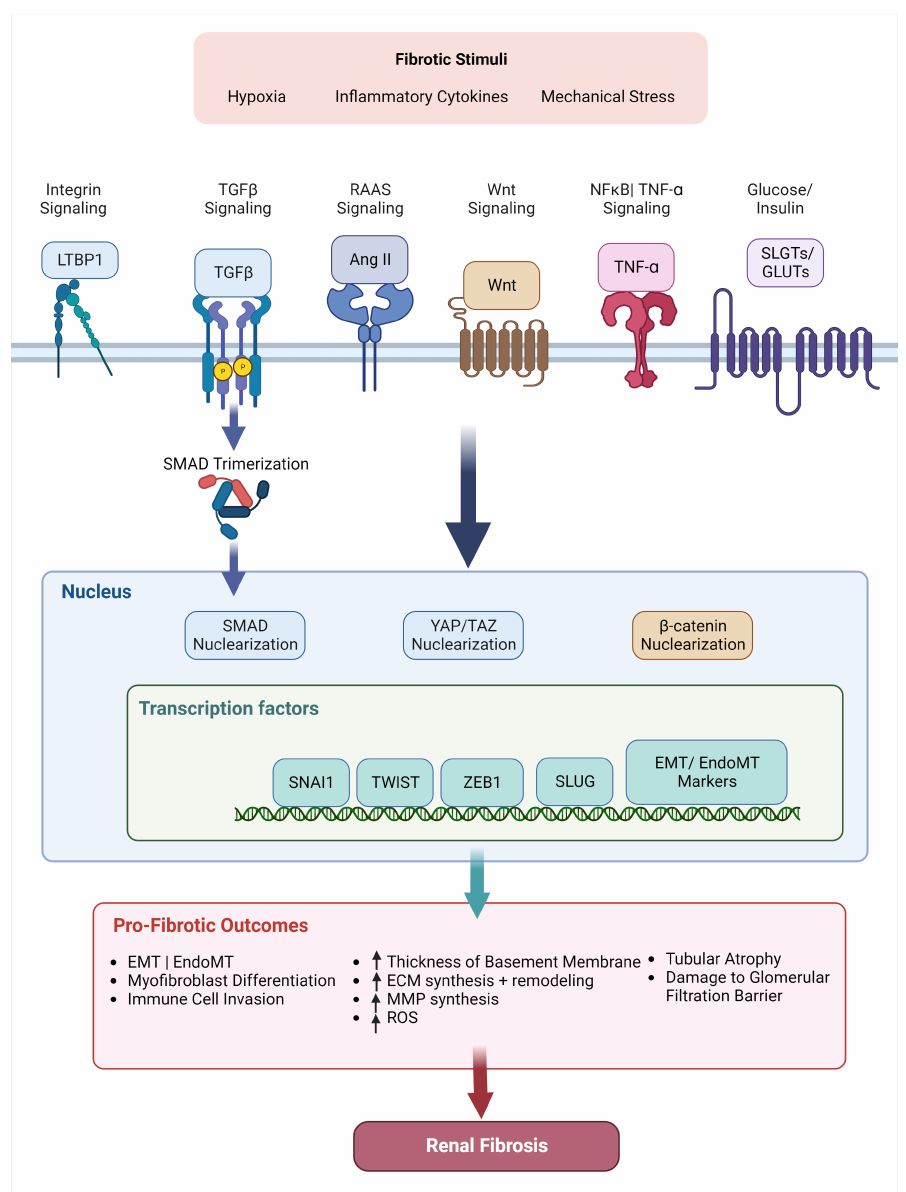
Figure 3. Relevant signaling pathways that drive renal fibrosis. Activation of pathways (Integrin, RAAS, TGF- β , Wnt, NF κ B, and Glucose) drive increased transcription of profibrotic factors such as Snail, Twist, Zeb1, and Slug. Increased expression drives a number of profibrotic outcomes such as EMT and EndoMT in epithelial cells and endothelial cells respectively. Figure generated using